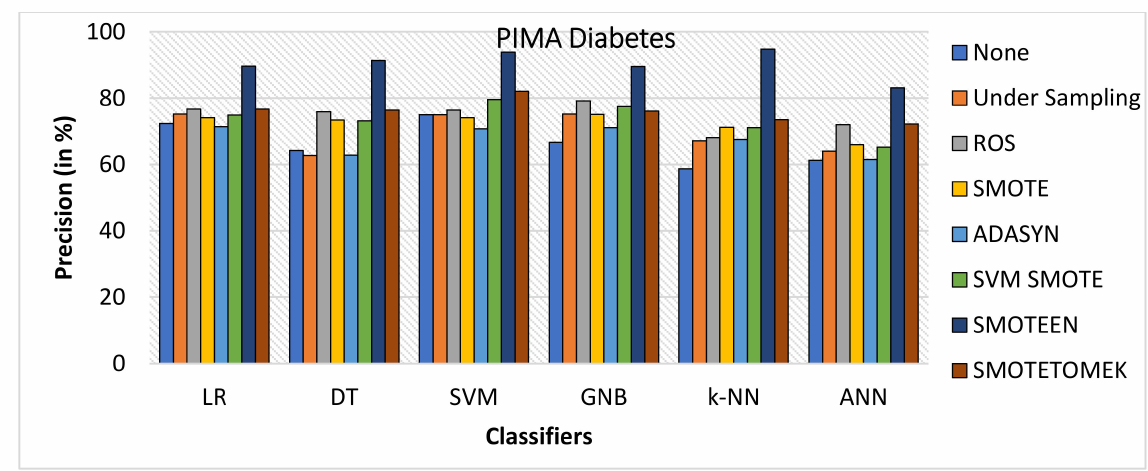
Figure 23. Precision for diabetes dataset of balancing algorithms over six